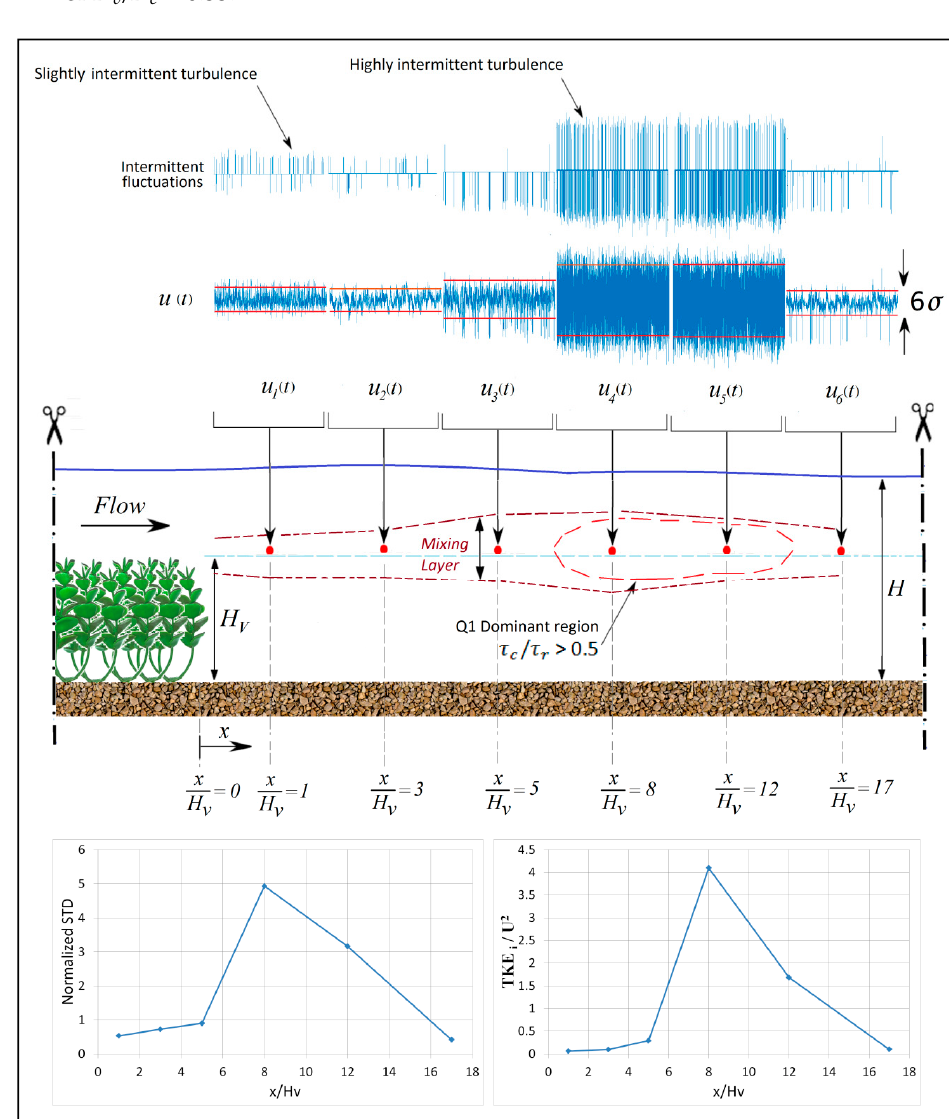
Figure 11. Formation of the intermittent fluctuations in the mixing layer beyond the patch (case 1). The filtered velocity time series is shown as intermittent fluctuations above the original velocity time series. Variations in the normalized standard deviation of TKE and normalized intermittent Turbulent Kinetic Energy are shown at the bottom.